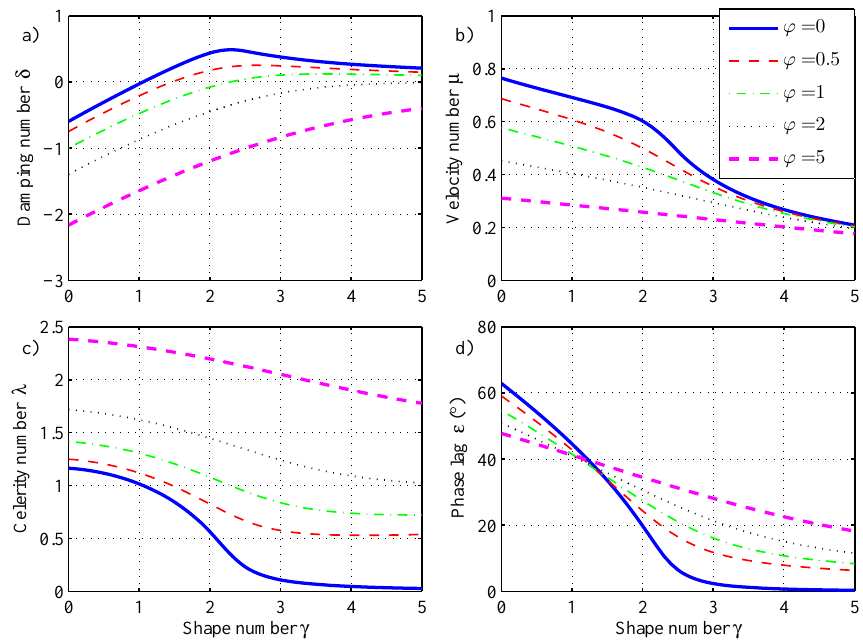
Fig. 7. Relationship between the main dimensionless parameters and the estuary shape number γ obtained by solving the Eqs. (11) (with 0 = 0 H ), (30) and (31) for different values of the dimensionless river discharge term ϕ with ζ 0 =0.1, χ 0 =20 and r S